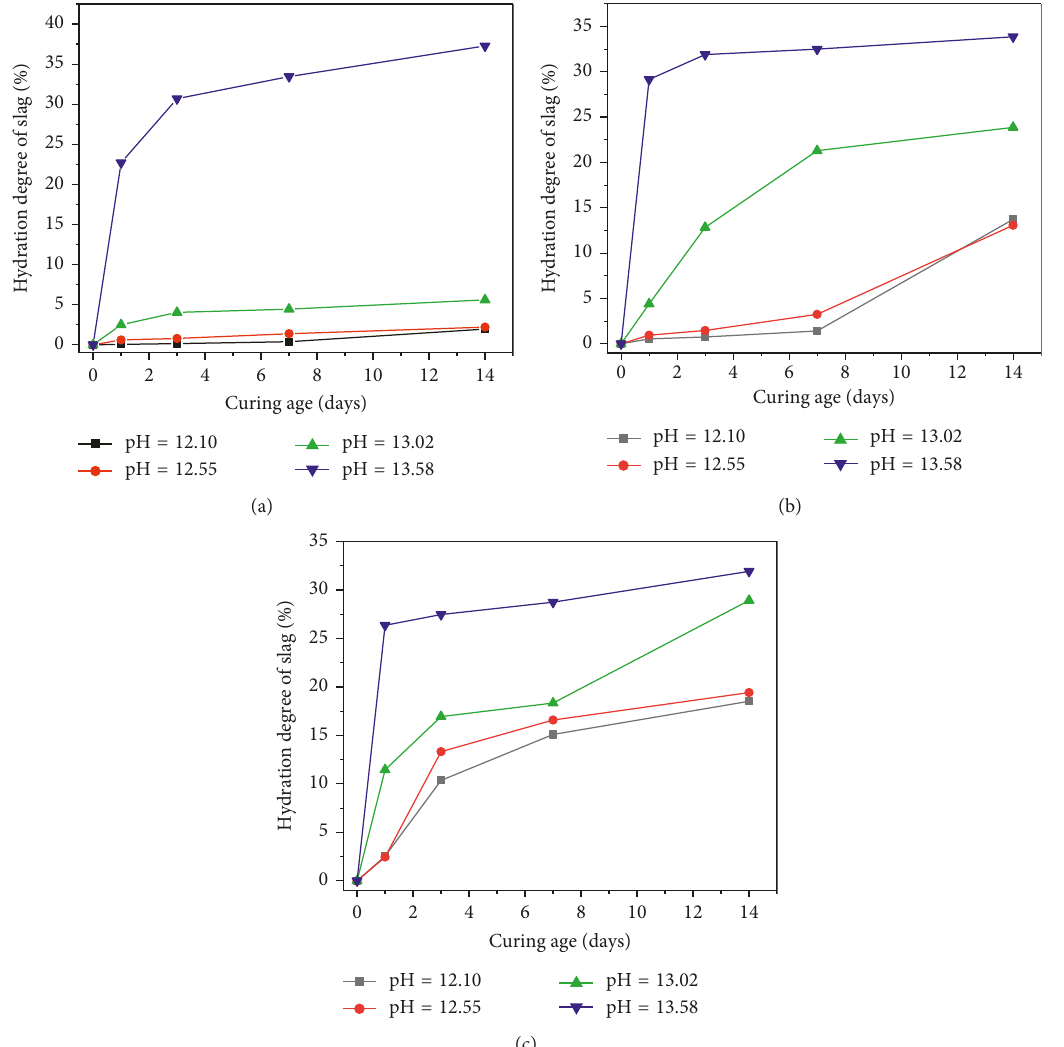
Figure 2: Water-to-slag ratio � 0.4; early hydration degree of slag changes with age at (a) 5 ° C, (b) 20 ° C, and (c) 35 °